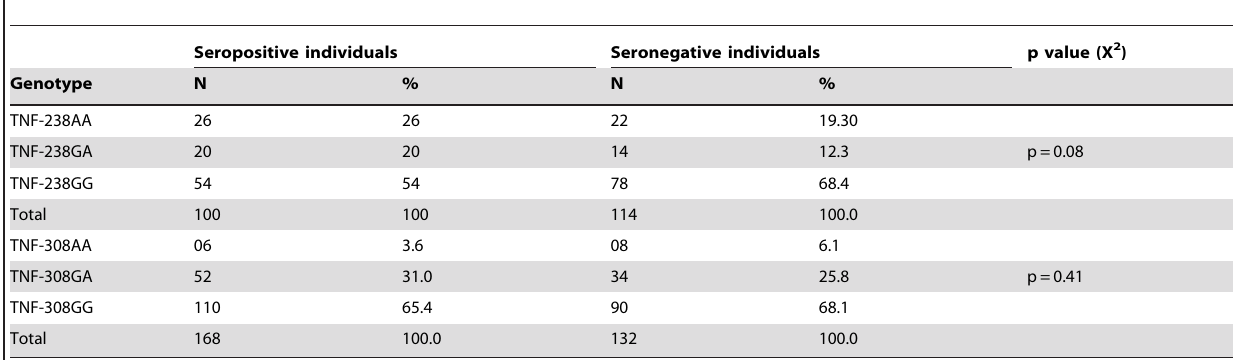
Table 1. TNF-alpha genotypes found in subjects from an endemic area according to the presence or absence of infection.